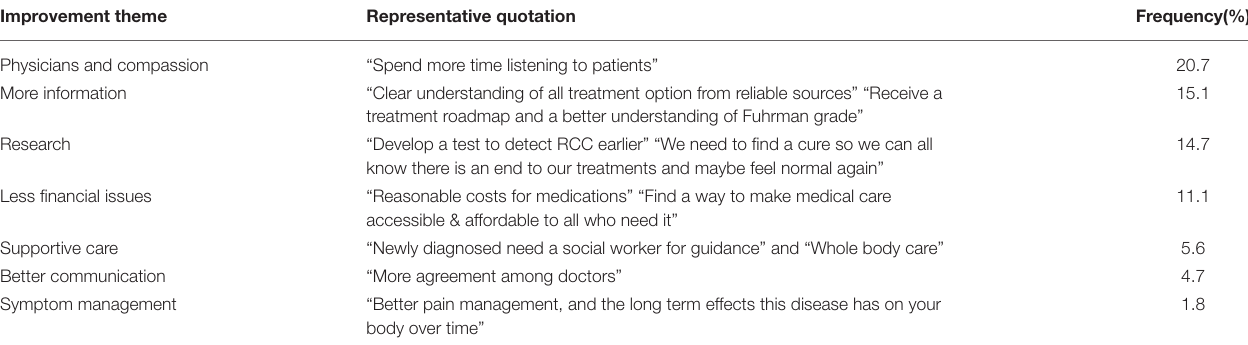
TABLE 2 | Solutions proposed by survey respondents with RCC, with semi-qualitative characterization of